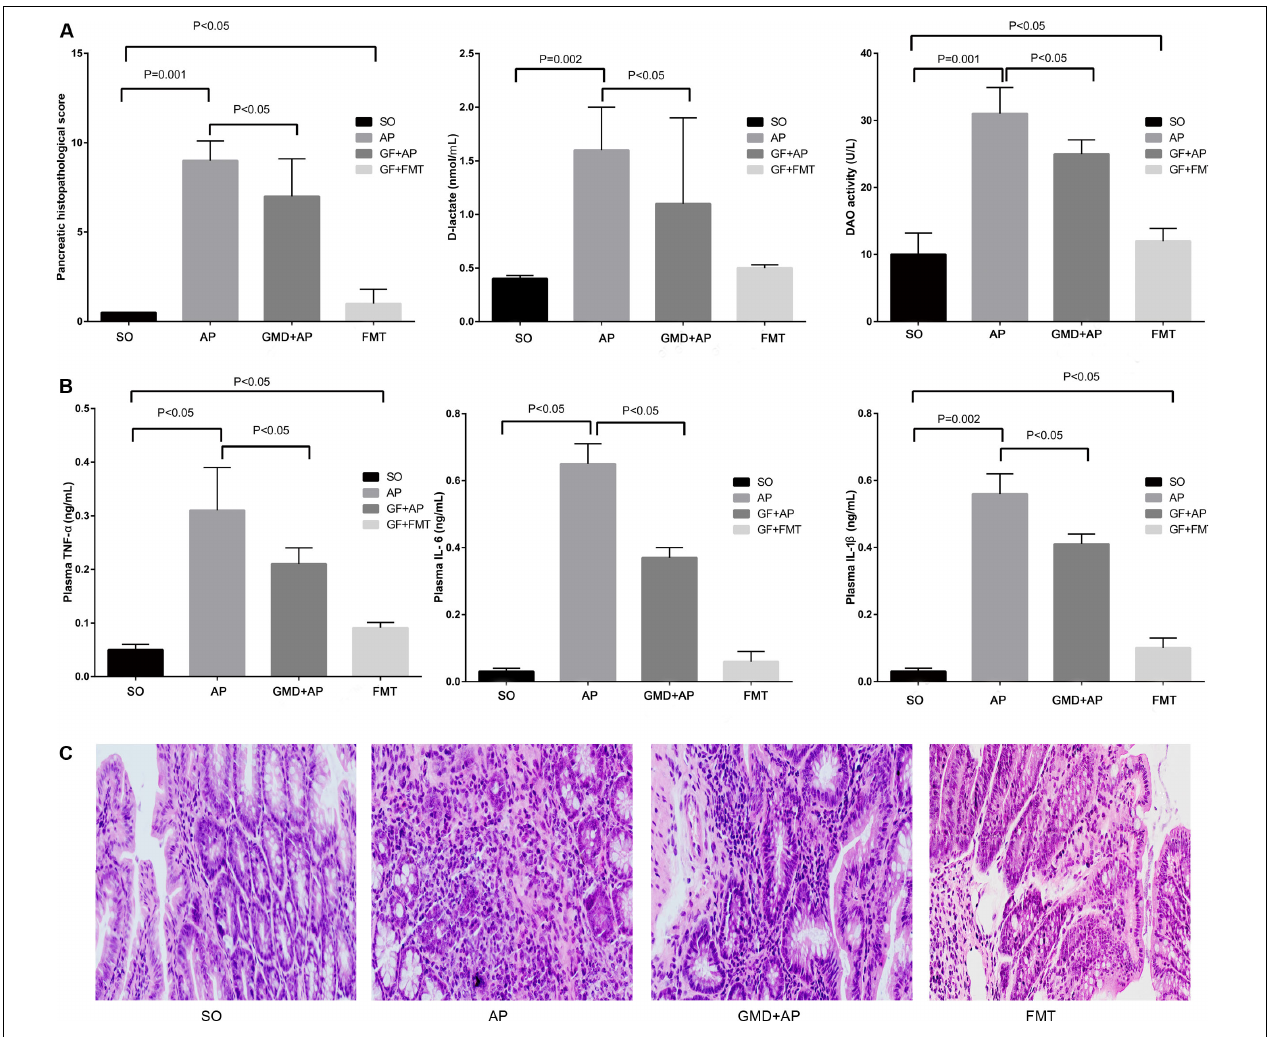
FIGURE 2 | Acute pancreatitis gut microbiota worsen pancreatitis. (A) Changes to pancreatic histopathology, plasma D-lactate, and diamine oxidase between sham-operated (SO), acute pancreatitis (AP), gut microbiota-depleted (GMD), and fecal microbiota transplantation (FMT) mice. Stool supernatant from AP mice was fed by gavage to GMD mice for 3 days to create fecal microbiota-transplanted (FMT) mice. (B) Changes to levels of intestinal inflammatory cytokines (tumor necrosis factor α , IL-1 β , and IL-6). (C) Histological analysis of the ileum in the SO, AP, GMD + AP, and FMT